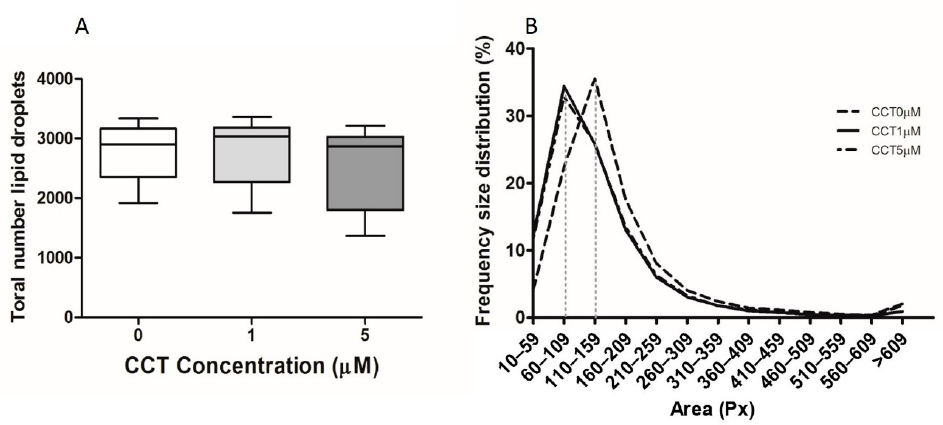
Figure 3. E ff ect of CCT on the number and size of lipid droplets. ( A ) Final lipid droplet number. Box-and-whisker plot depicting the minimum to maximum values, with the middle line representing the mean ± SD. ( B ) Intervals of frequency–area distribution. The vertical dotted line indicates the